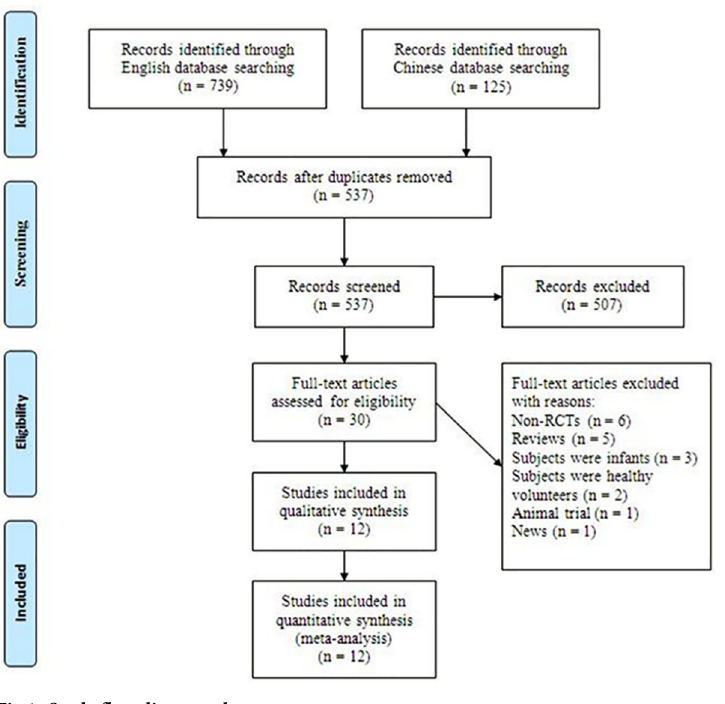
Fig 1. Study flow diagram